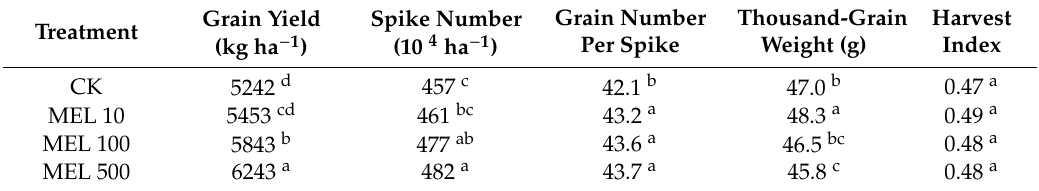
Four MEL concentrations were applied: 0 µ M (CK), 10 µ M (MEL 10), 100 µ M (MEL 100) and 500 µ M (MEL 500). Values are means of three replicates. Significant di ff erences between di ff erent treatments are indicated by di ff erent letters as a, b or c ( p < (MEL 500). Values are means of three replicates. Significant differences between different treatments are indicated by different letters as a, b or c ( p < 0.05).